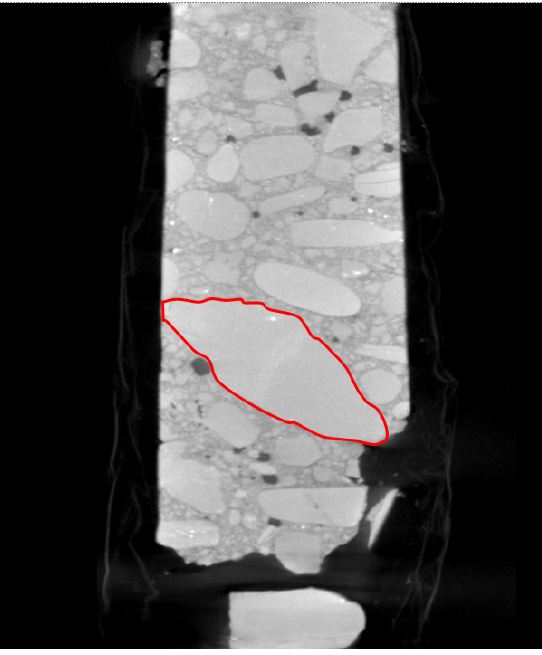
Figure 13. Uneven particle size distribution of coarse and fine